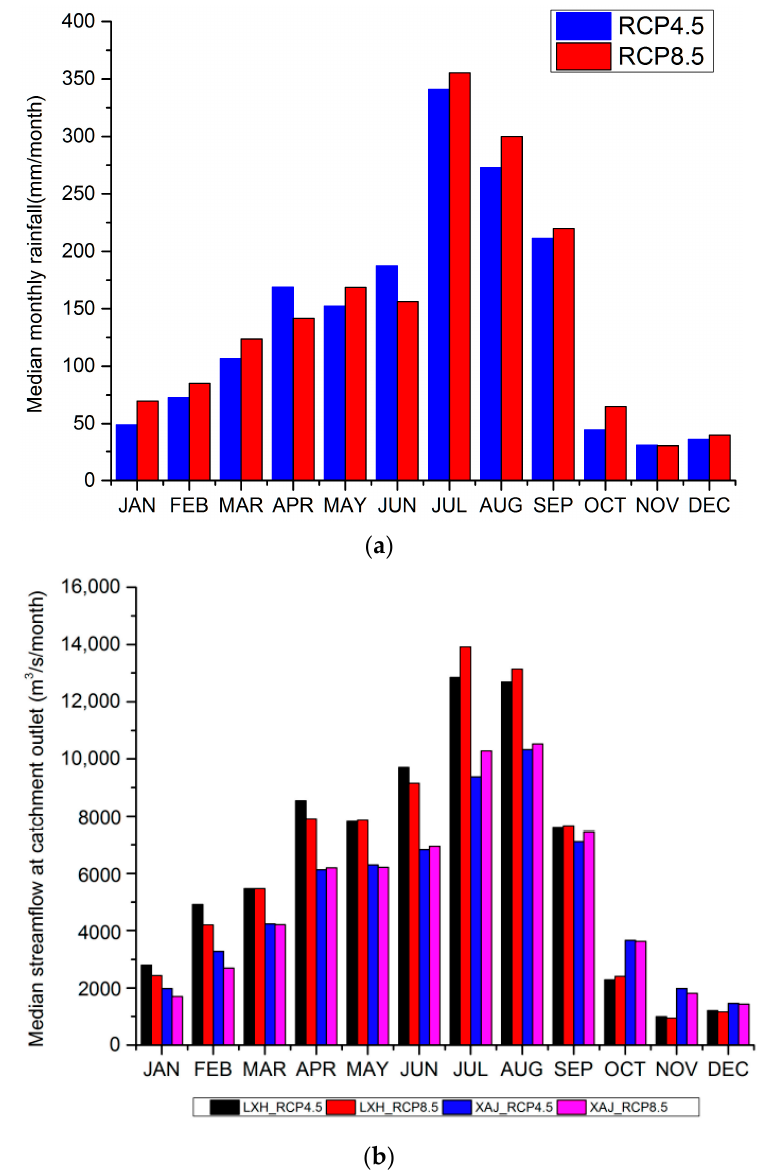
Figure 11. Comparisons of median monthly rainfall and flow simulation under two climate change scenarios in two hydrological models ( a : median monthly rainfall; b : median monthly streamflow).